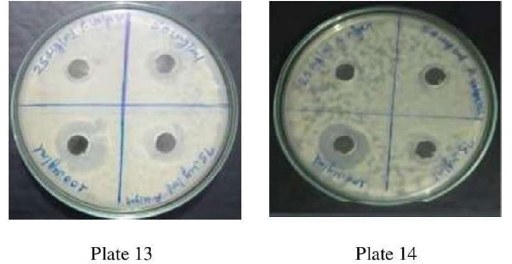
Fig. 10. Anti-fungal activity of methanolic extract of P. vulgaris.